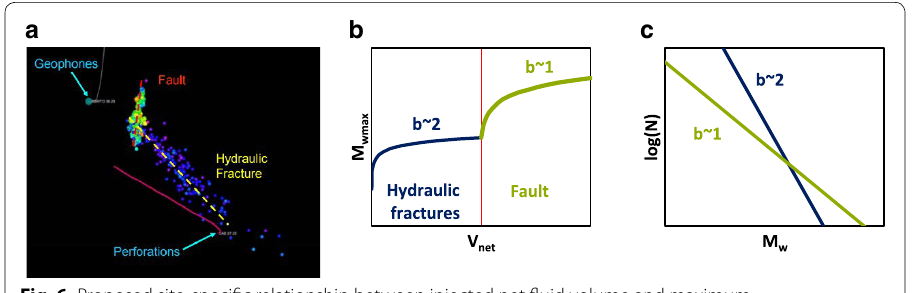
Fig. 6 Proposed site‑specific relationship between injected net fluid volume and maximum fluid‑injection‑induced seismic moment magnitude. a Higher magnitude seismic events in green indicate fault activation after a hydraulic fracture (characterized by lower magnitude seismic events in blue) develops from the injection point (perforations) and hits the fault (Maxwell et al. 2008). b Schematic of a hypothetical site‑specific magnitude–net volume relation that changes once the fluid pressure front reaches a fault. c Schematic of a hypothetical cumulative frequency ( N )–magnitude ( M w ) distribution of fluid‑injection‑induced seismic events caused by hydraulic fracturing ( b ~ 2) and fault activation ( b ~